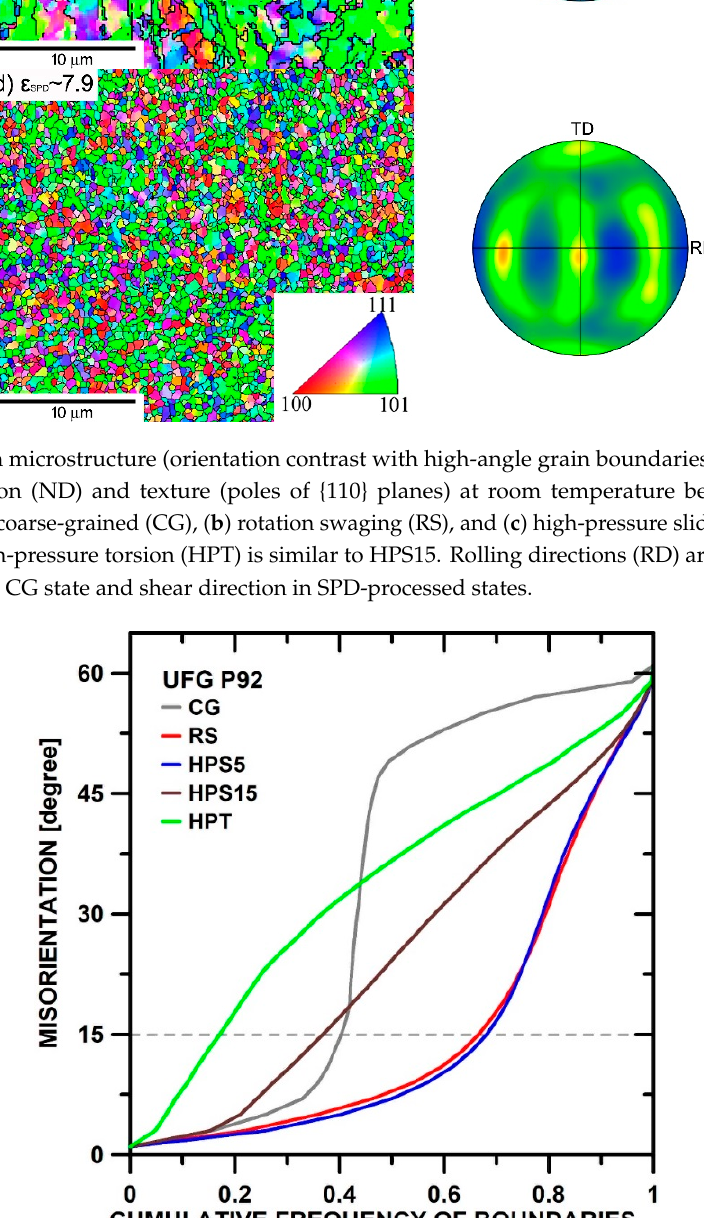
Figure 2. Misorientation: cumulative frequency F of boundaries with misorientations θ in CG (as-received) and predeformed P92. Intersection with the dashed line θ = 15 ◦ gives the low-angle grain boundaries (LAGB) fraction f HAGB = F ( 15 ◦ ).